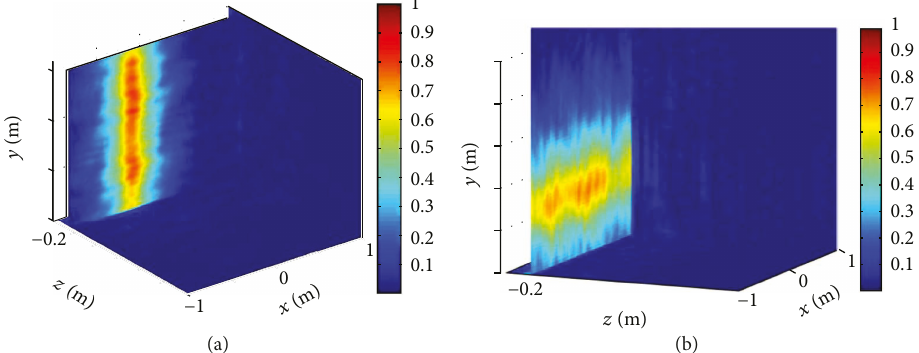
Figure 12: Imaging results using the proposed 3-D microwave tomographic algorithm for (a) vertically and (b) horizontally oriented mirror behind a solid concrete